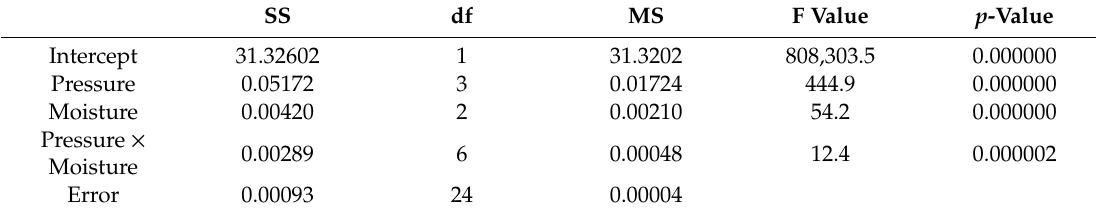
Table 6. Two-way ANOVA—DE.